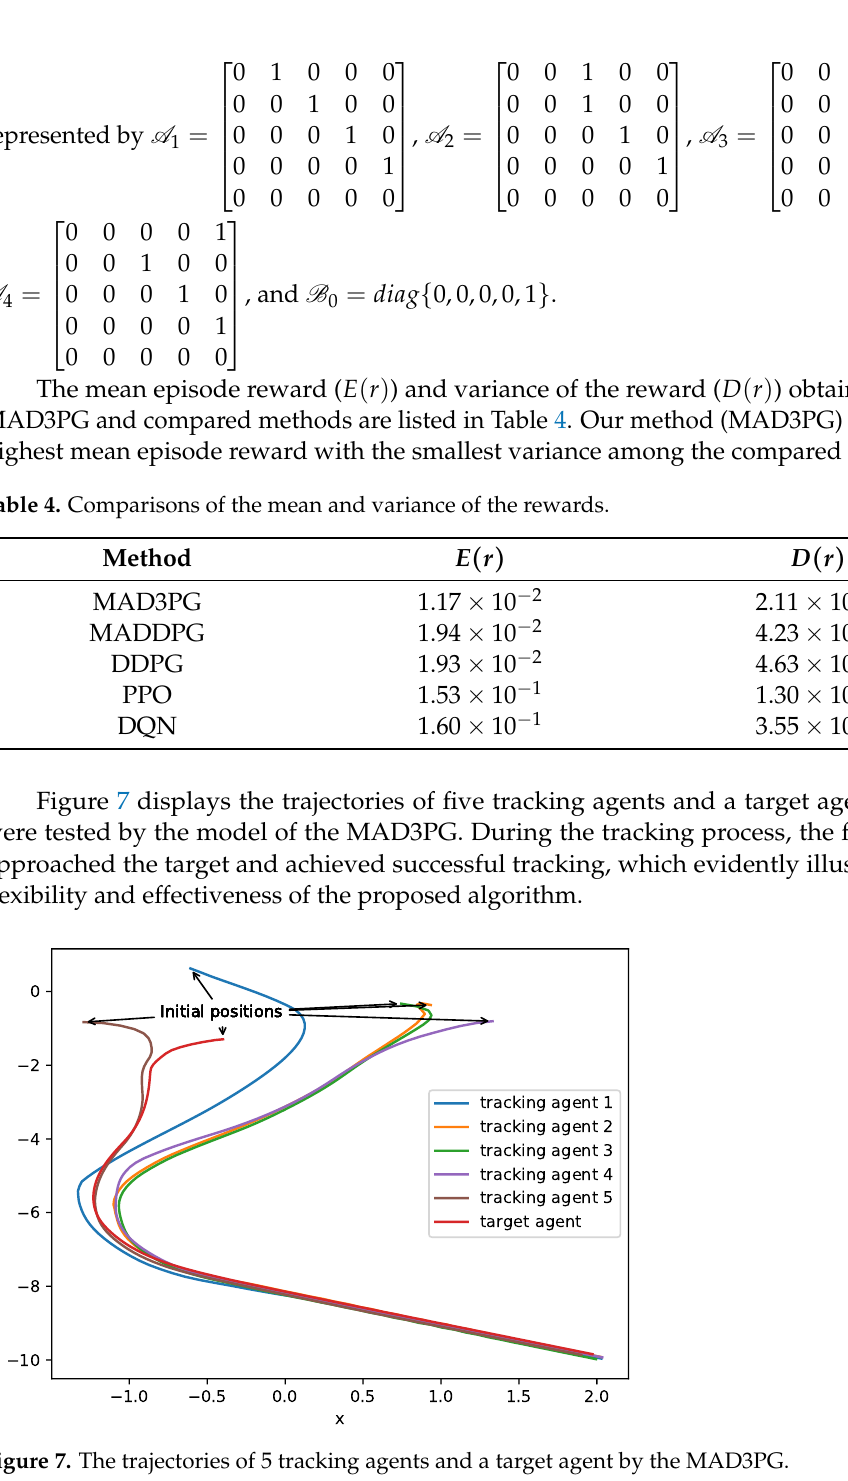
Figure 7. The trajectories of 5 tracking agents and a target agent by the